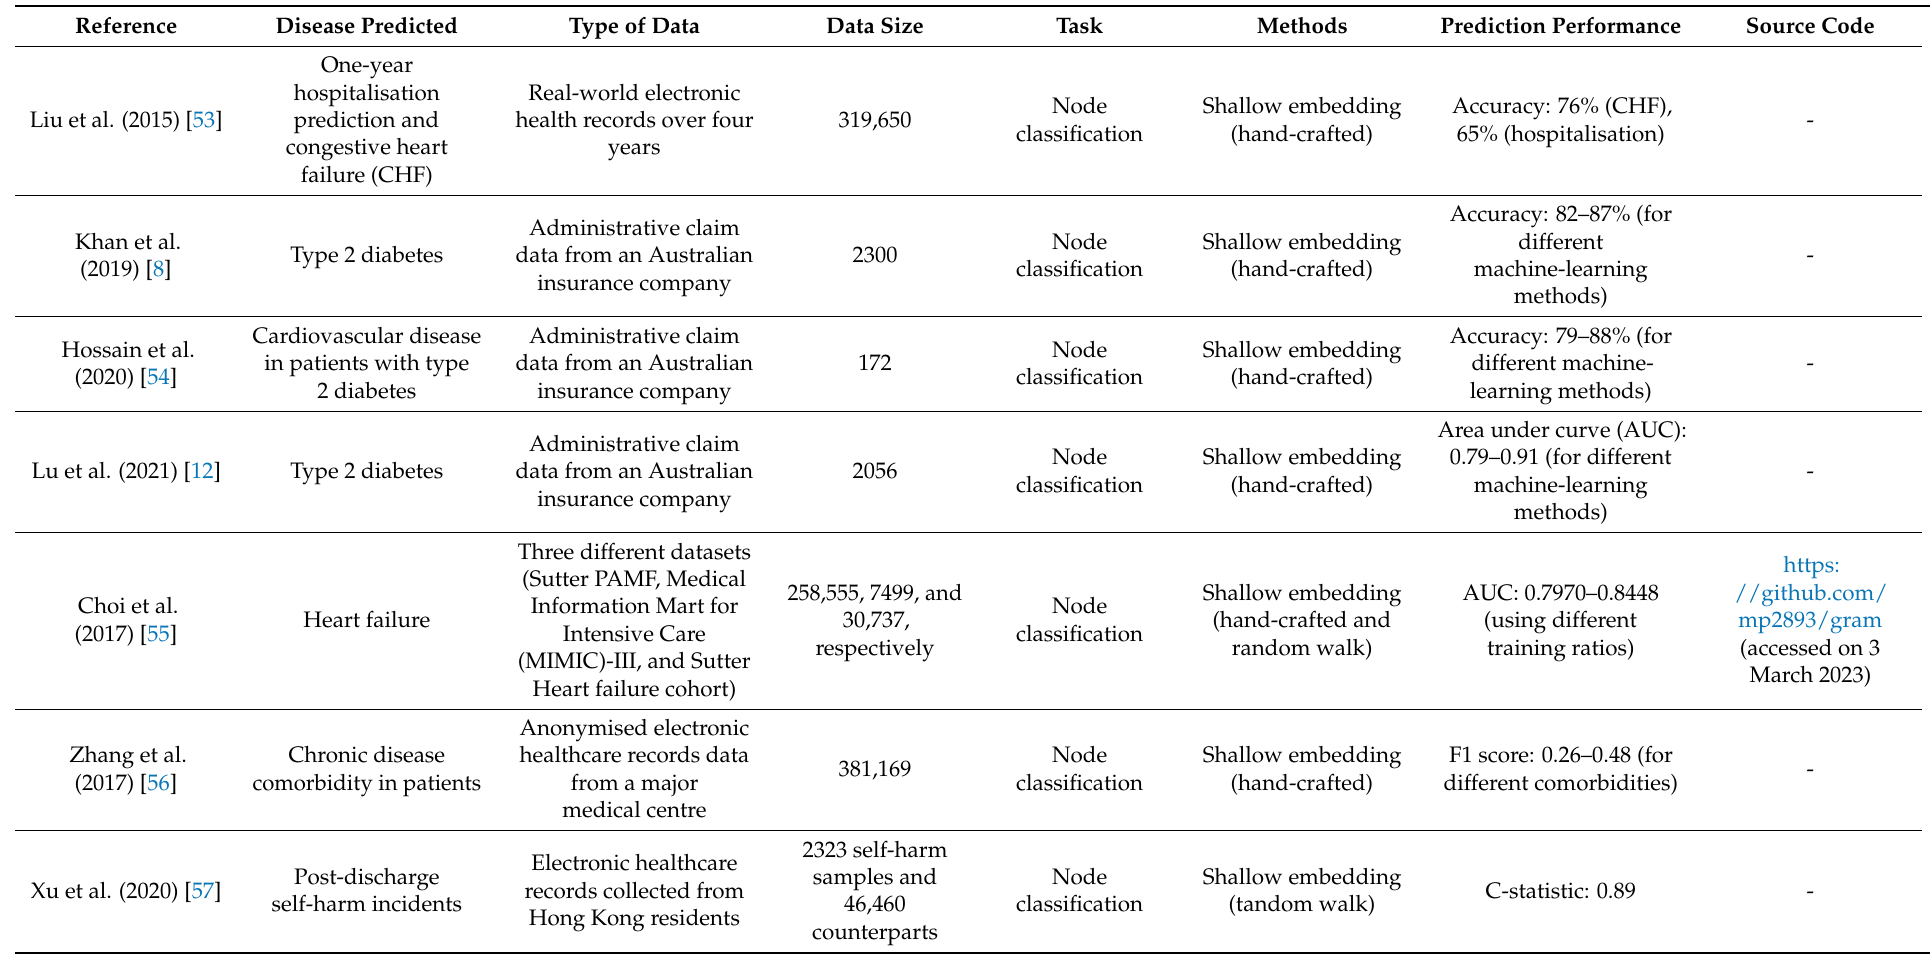
Table 1. Summary of the reviewed articles that used graph machine learning for disease prediction using electronic health